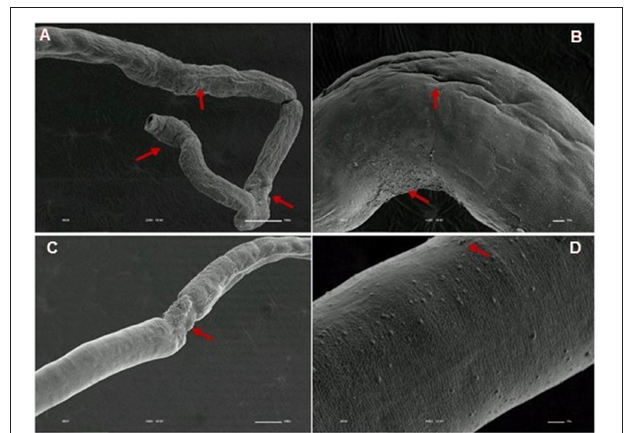
FIGURE 12 | Scanning electron microscopy of S. mansoni PZQ-resistant strain adult females after exposure to 0.3 µ M of PZQ for 3 h. (A) Resistant strain adult females upon exposure to PZQ, presenting changes in oral suckers; (B) light peeling in the worm ventral region; (C,D) alterations in some tegumental areas. Red arrows indicate alterations. Image marginations: (A) 220x 10 kV ________100u; (B) 550x 10 kV ________10u; (C) 160x 10 kV ________100u; (D) 900x 10 kV